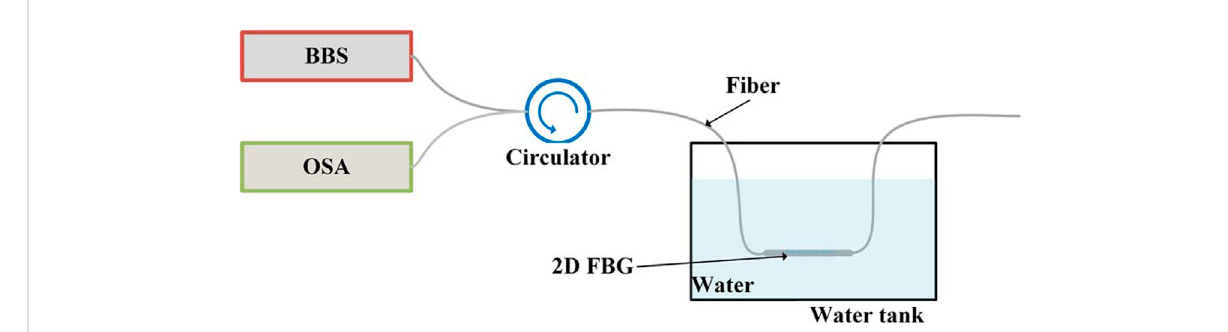
FIGURE 3 The schematic diagram for the fabricating system of 2D FBG.